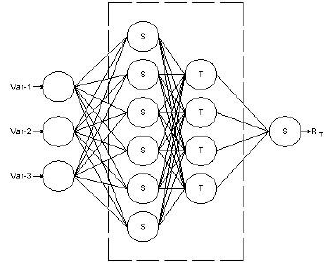
Figure 9. Architecture of the selected ANN model.